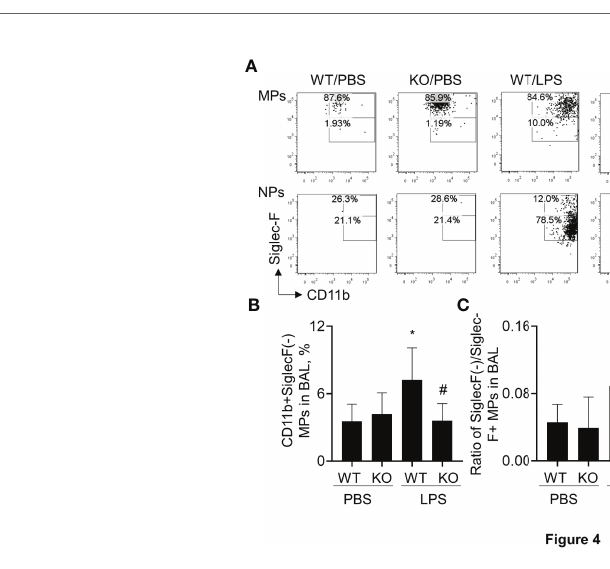
FIGURE 4 | Lack of SIRP-alpha expression attenuated CD11b+Siglec-F(-) subtype macrophages and neutrophils in murine ALI. (A) Flow cytometry analysis for CD11b+Siglec-F(-) subtype MPs and NPs in BAL of murine ALI. CD11b+Siglec-F(-) subtype MPs and NPs were gated on MPs and NPs, respectively. Representative dot plot. (B) Quantitative analysis of CD11b+Siglec-F(-) subtype MPs in BAL. (C, D) Ratio of CD11b+Siglec-F(-) subtype MPs/CD11b+Siglec-F+ subtype of MPs and NPs in BAL. Data was presented as mean ± standard deviation, *p<0.05, **p<0.01 vs. PBS group; #p<0.05, ## p<0.01 vs. WT group for (B – D) . n=5-6. One-way ANOVA followed by Tukey ’ s multiple comparisons test. (E) Correlation analysis between the expression of IL-6 in BAL and ratio of Siglec-F(-) subtype/Siglec-F+ subtype NPs in BAL. Each point presents individual